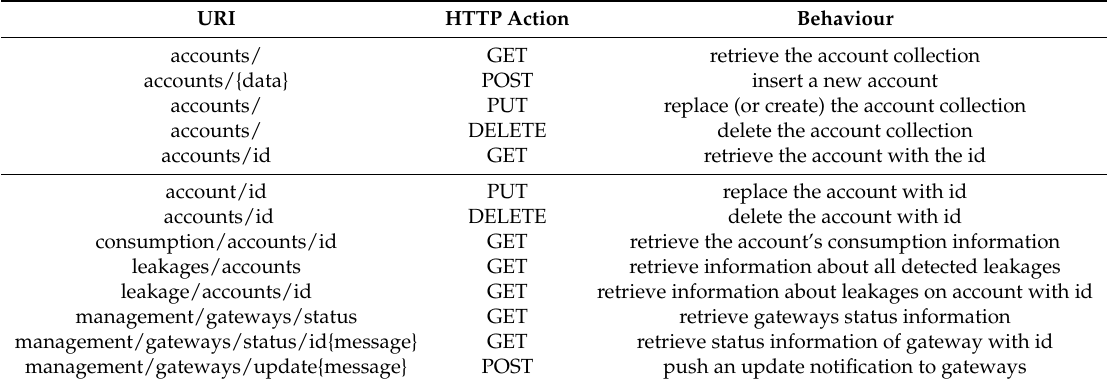
Table 1. SWaMM ReST